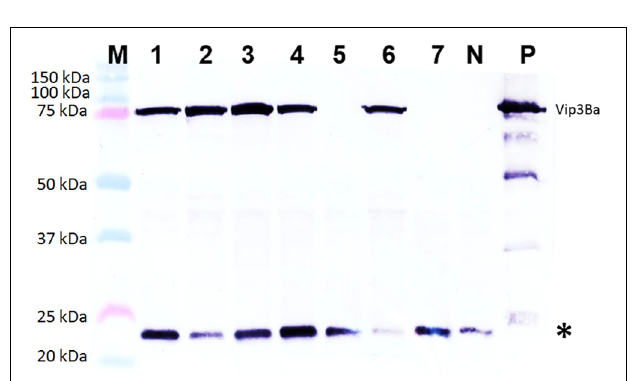
FIGURE 4 | Western blot analysis of Vip3Ba expression in seven T 1 progeny derived from transgenic cowpea line 43. Lane M: Protein precision markers; Lanes 1 to 7: Protein (40 µ g) extracts from leaves of seven T 1 plants of line V43; Lane N: protein from line IT86D-1010 (negative control); Lane P: 100 ng of Vip3Ba protein from Escherichia coli expressing Vip3Ba (positive control). Vip3Ba band migrates at ∼ 75 kDa. The 22 kDa band ( ∗ ) in all lanes including the negative control represents an unknown protein that cross-reacts with the monoclonal